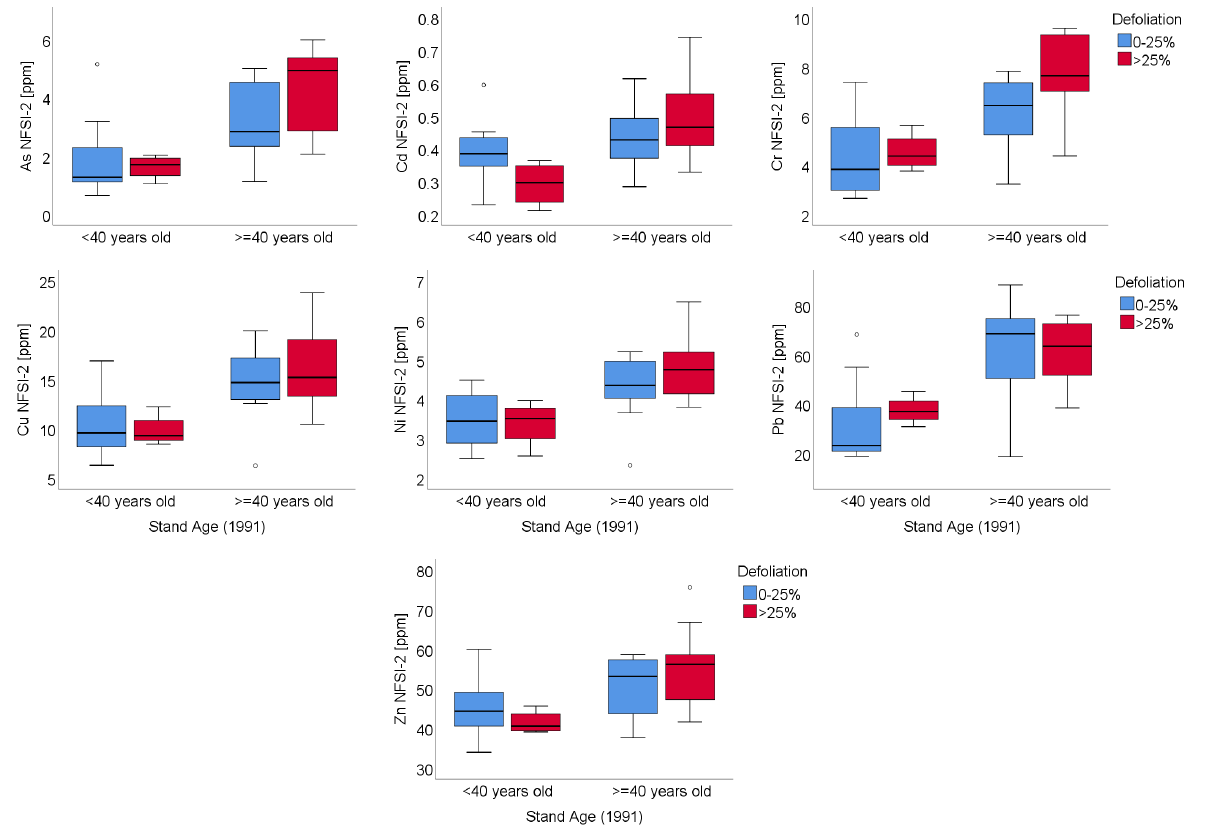
Figure 8. Box plots of the contents of As, Cd, Cr, Ci, Ni, Pb and Zn in the humus layers of pine stands differentiated according to stand age and crown condition (percentage needle